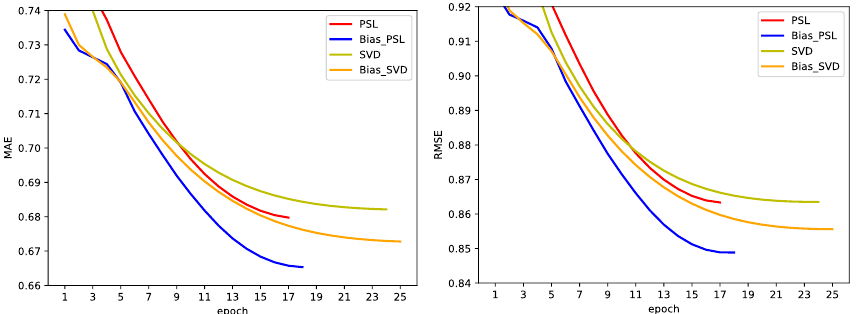
Figure 4. Training process of compared models on MovieLen-1 M with 50 latent